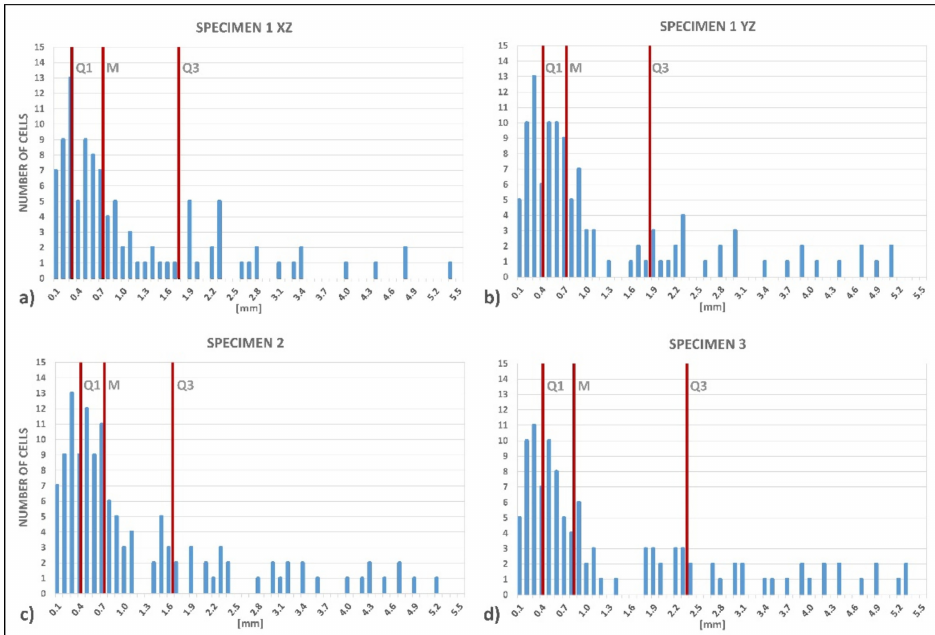
Figure 13. Analysis and comparison of the distributions of the equivalent diameter D eq : ( a , b ) Longitudinal sections XZ and YZ of reference Specimen 1, as defined in Figure 2; ( c , d ) Longitu- dinal sections (randomly chosen) of Specimens 2 and 3.